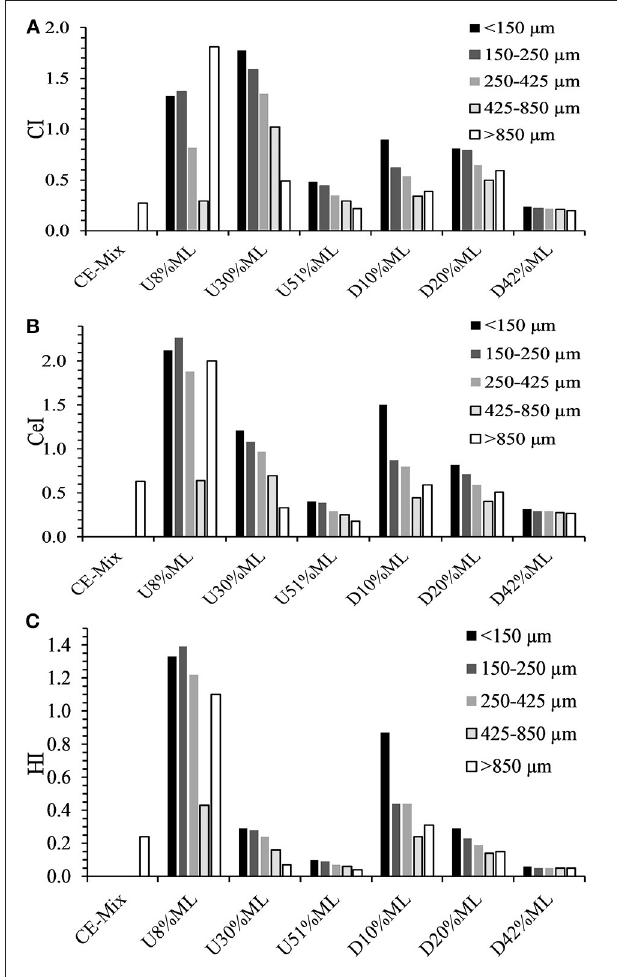
FIGURE 9 | FTIR spectra of (A) CE-fiber mix and ground/screened (425–850 µ m) torrefied (10, 20, and 42% mass loss) densified material and (B) ground/screened ( < 150 µ m, 150–250 µ m, 250–425 µ m, 425–850 µ m, and > 850 µ m) un-densified torrefied (30% mass loss) material.